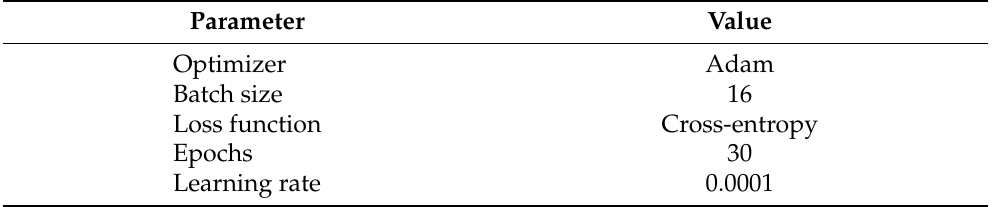
Table 4. Training settings for all